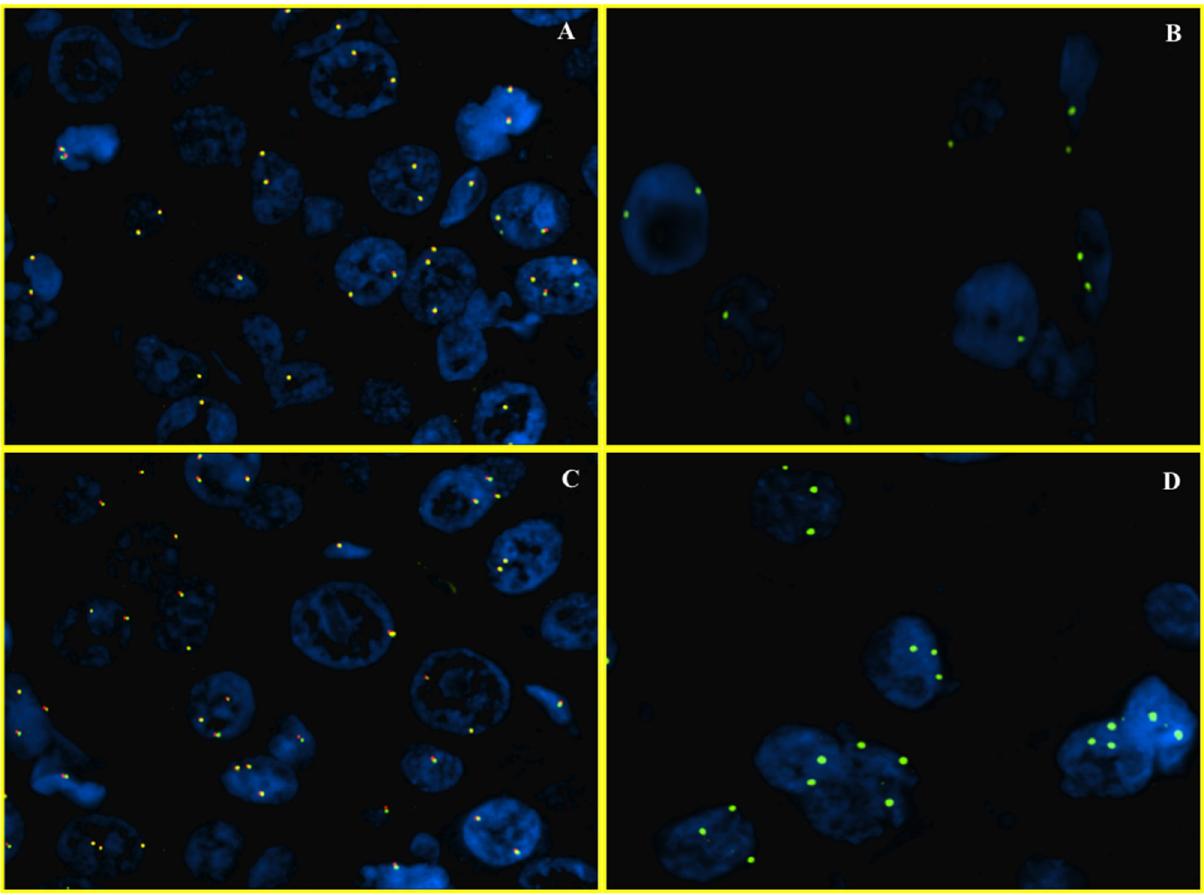
Figure 2. FISH analysis of c-myc (wild status and gains of 8q). Dual color fluorescence in situ hybridization with a centromere probe for chromosome 8 (CEP8, Spectrum Green), and region-specific probe for c-myc (Spectrum Orange), in representative foci of hepatocellular carcinoma. In the first two images, HCC nuclei have 2 signals both for c-myc gene (A) and for chromosome 8 (B). This case has a normal disomic status. In the other two images there are >10% of nuclei with 3 signals for c-myc (C) and for chromosome 8 (D). This case is representative of a gain for chromosome 8 (trisomy).